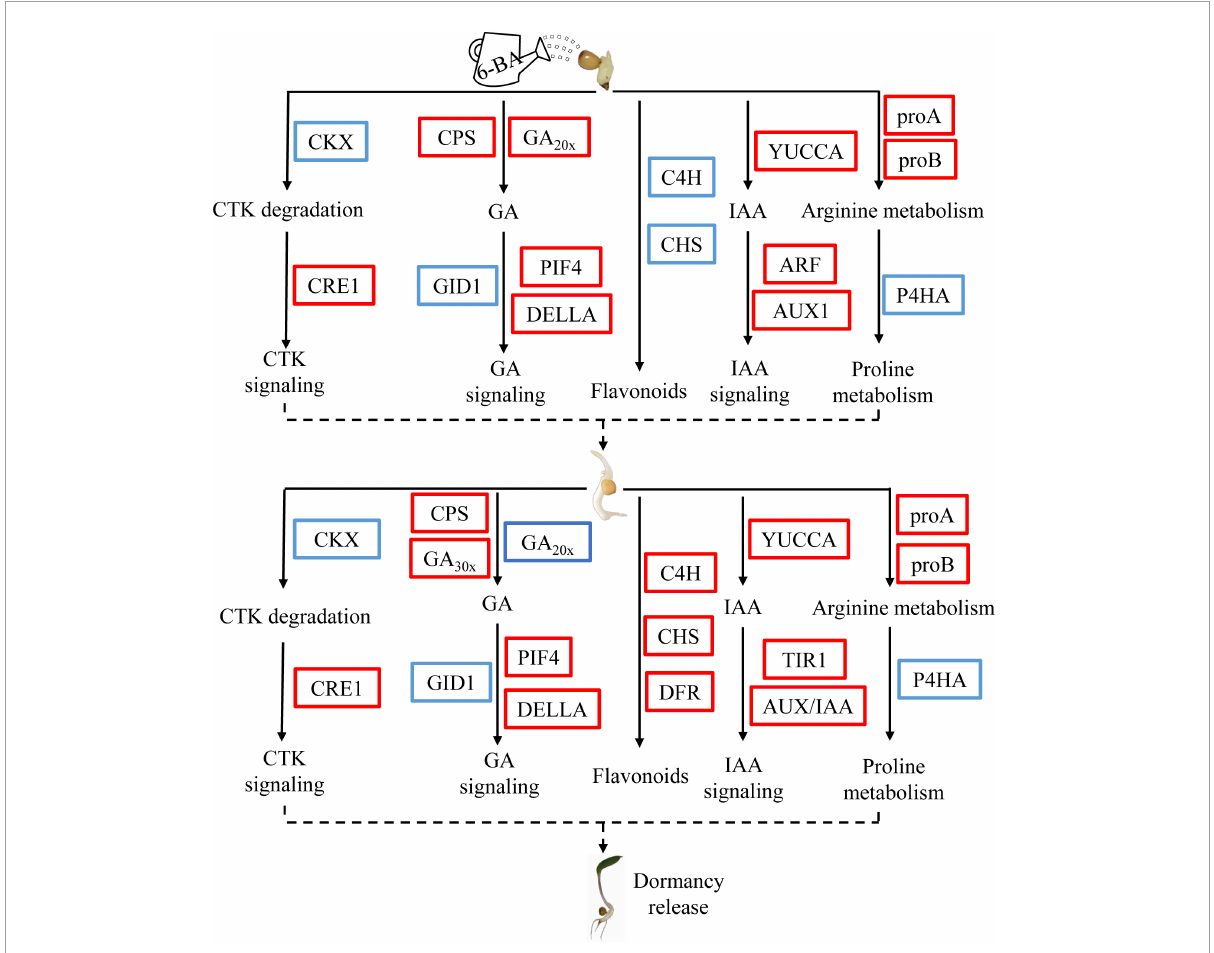
FIGURE7 Schematic model showing the changes of a metabolic pathway in the critical period of epicotyl dormancy release of P. cyrtonema seeds. The red box and blue box indicate upregulated and downregulated genes in this pathway,